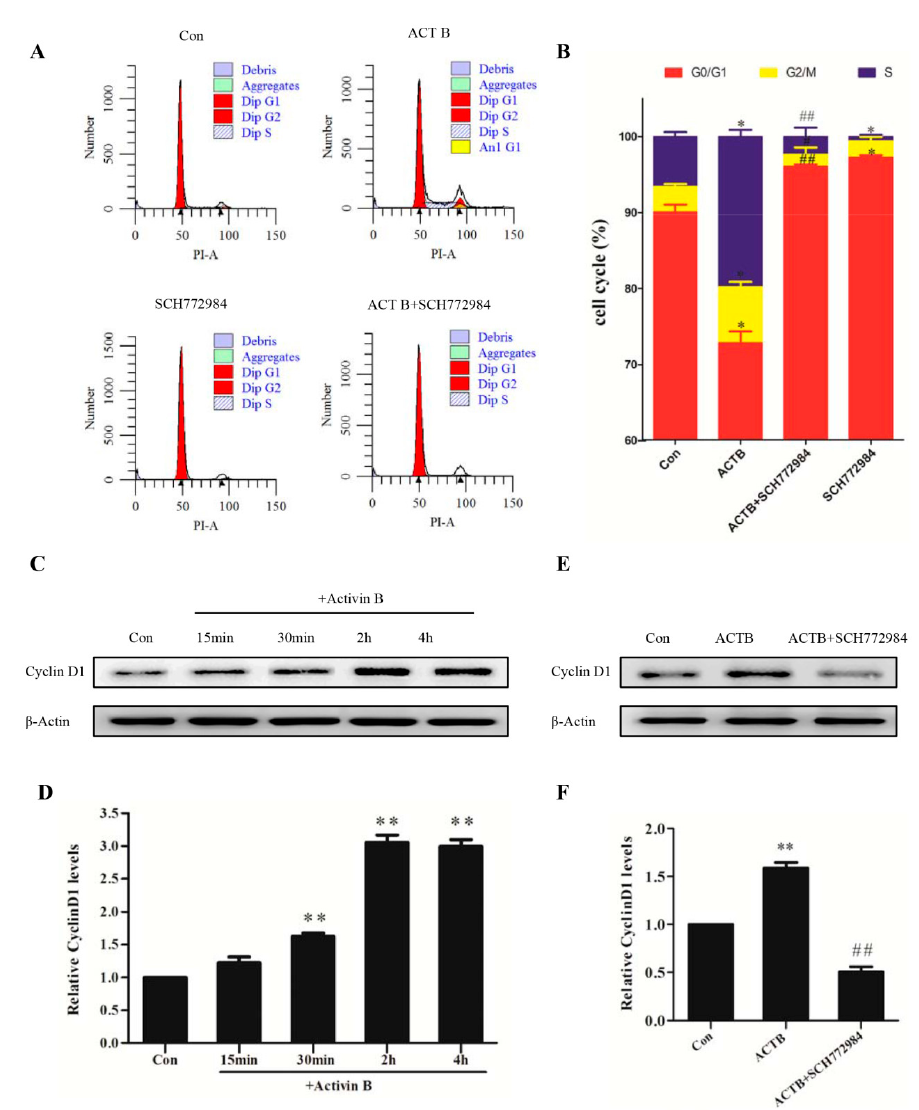
Figure 5. Activin B accelerated the cell cycle transition of HHGMCs from the G0/G1 phase to the S phase through the ERK–Cyclin D1 pathway. ( A ) HHGMCs were serum starved for 24 h and pretreated with or without SCH772984 (5 µ M) for 2 h. After treatment with 10 ng/mL Activin B or PBS for 48 h, the cell cycle distribution was measured by flow cytometry using propidium iodide (PI) staining. ( B ) The percentages of cell cycle phase in G0/G1, S, and G2/M are shown in a bar graph form. ( C , D ) The plot and the relative quantification of the expression of Cyclin D1 in the cells treated with 10 ng/mL Activin B for 15 min, 30 min, 2 h, and 4 h. ( E , F ) The plot and the relative quantification of the expression of Cyclin D1 in the cells pretreated with SCH772984. * p < 0.05; ** p < 0.01, compared with the PBS group. # p < 0.05; ## p < 0.01, compared with Activin B group. Three independent experiments were conducted per data point. All error bars indicate SEM.